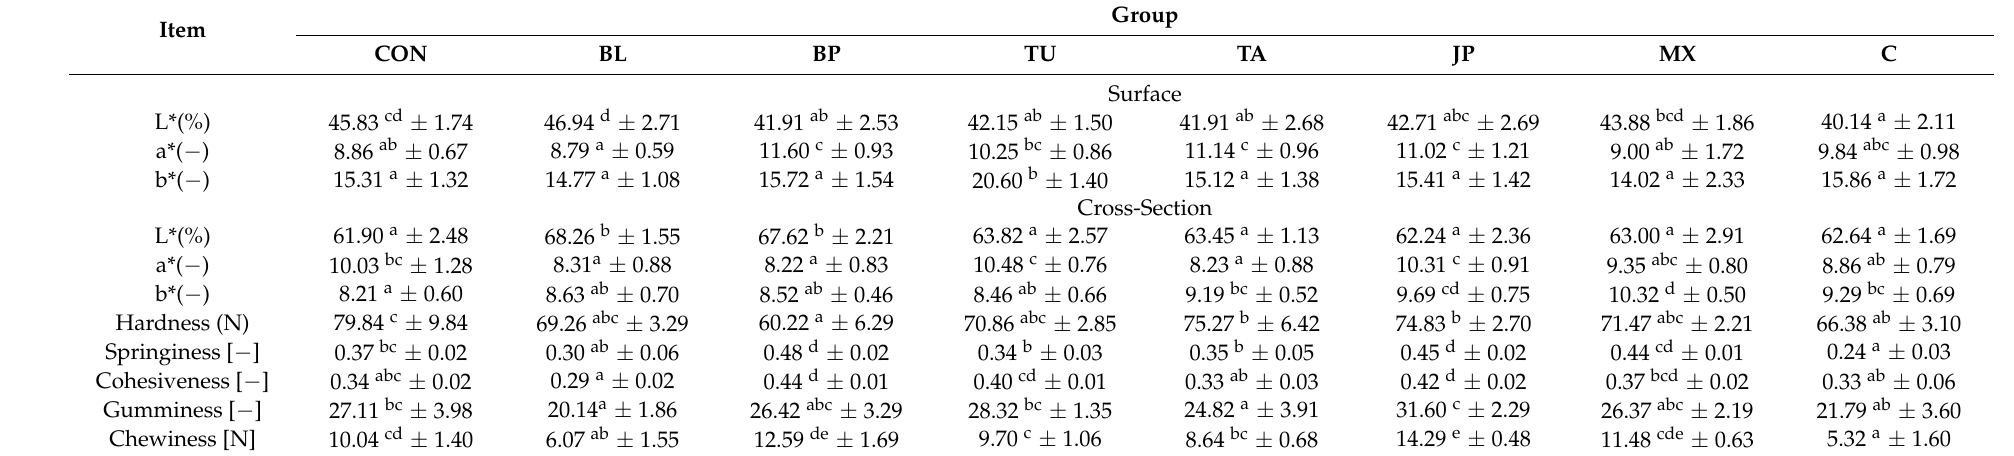
Table 6. The effect of marinade on colour and texture parameters (mean ± standard deviation) of grilled